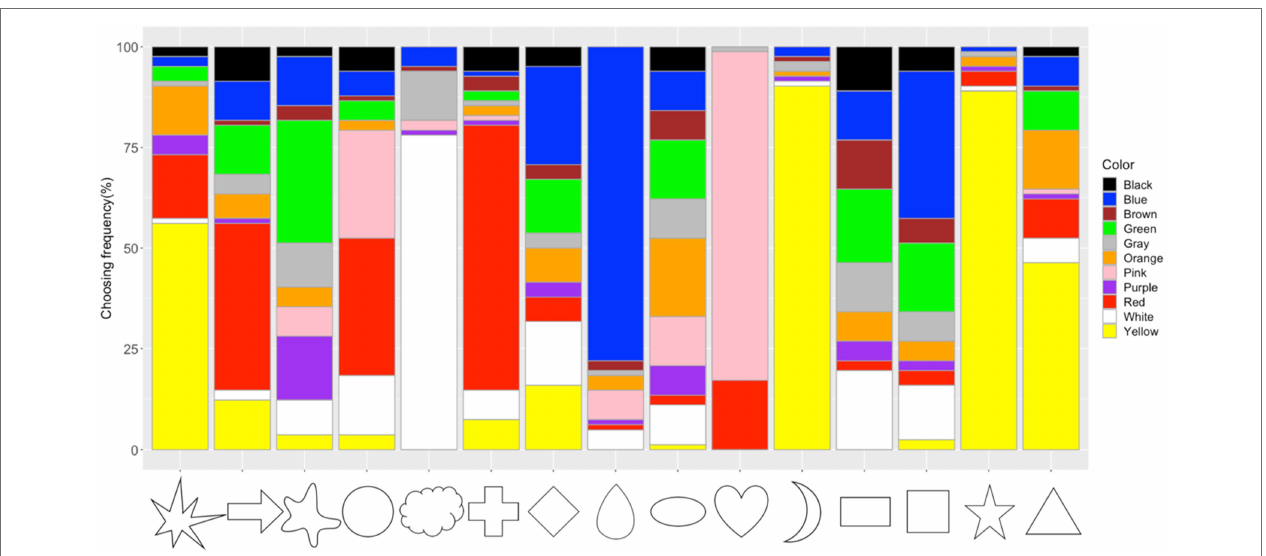
FIGURE 7 | Frequency of color choices for each